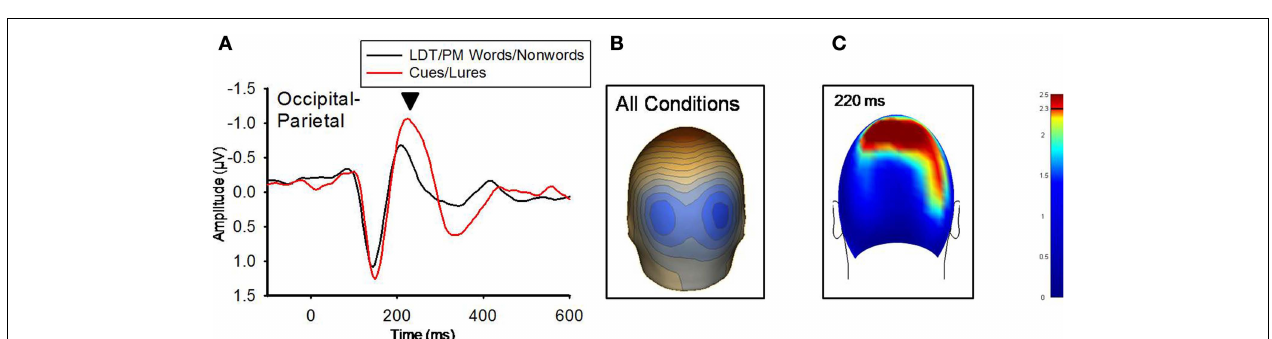
FIGURE 2 | (A) Grand-averaged ERP waveforms for LDT-words/nonwords and PM- words/nonwords for the 140 ms (marked with black arrow) and 220 ms (white arrow) components. ERP waveforms depicting the 140 and 220 ms effects were derived by averaging sensors from signifi cant clusters that resulted from the respective planned contrasts. The bottom panel depicts ERP waveforms for LDT- nonwords and PM-nonwords for the 400 ms (gray arrow) component, and these waveforms were derived from electrode Cz which best represented the difference around 400 ms. Negative is plotted up. (B) Topographical voltage distributions averaged within time windows centered on the peak latency of each component for which there were signifi cant effects. Positive isopotential lines are in red,